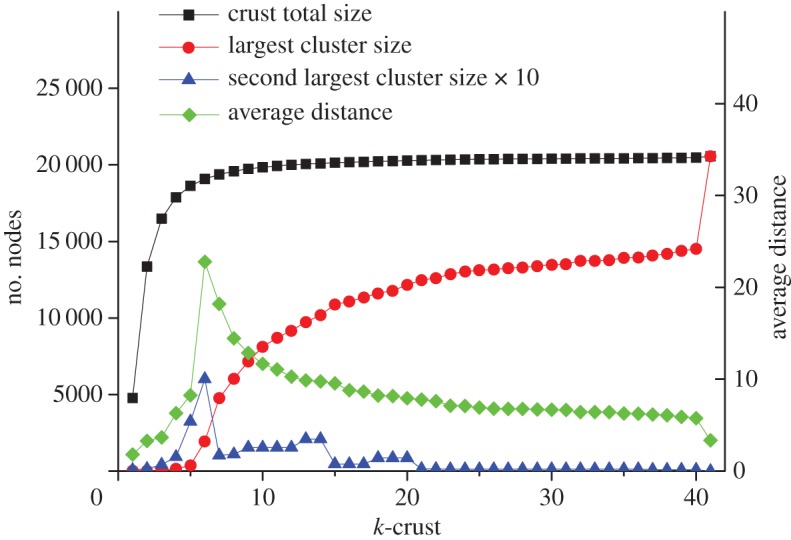
Characteristics of the k-crusts (adapted from [6]).